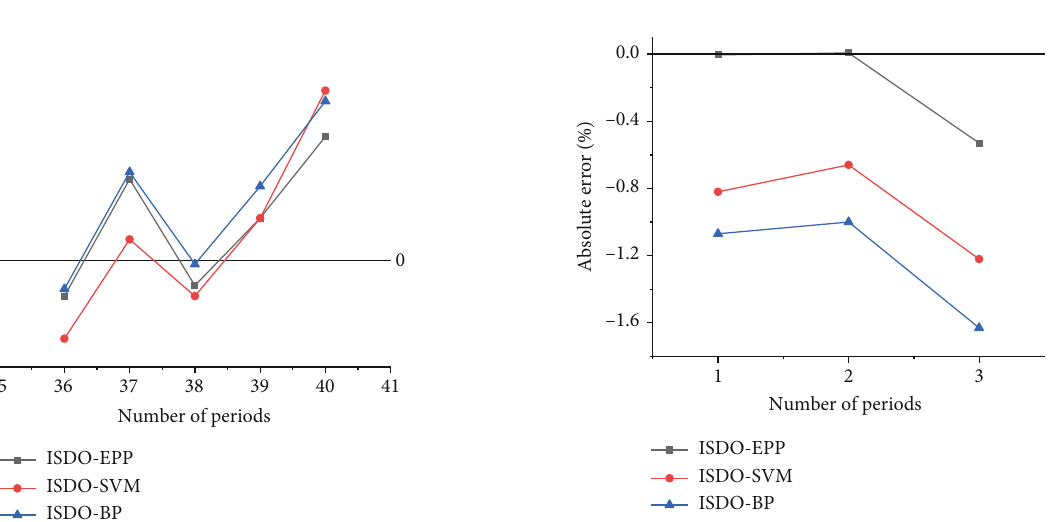
Figure 2: Absolute error of three models in example 1.